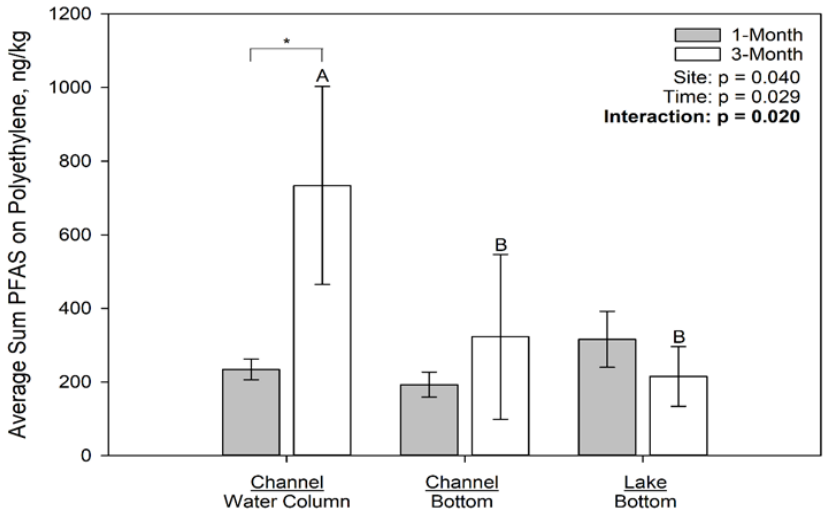
Figure 3. Average Sum of 7 PFAS (ng/kg) on Polyethylene Deployed at Different Locations in Muskegon Lake, MI. Different letters among bars indicate statistically significant differences among sites for either the 1 month or 3 month incubation period. Asterisks indicate statistically significant differences between the 1 month vs. 3 month incubation at a specific site.